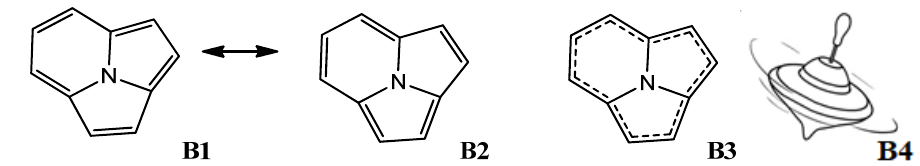
Scheme 2. Different images of the structure of cyclazine.